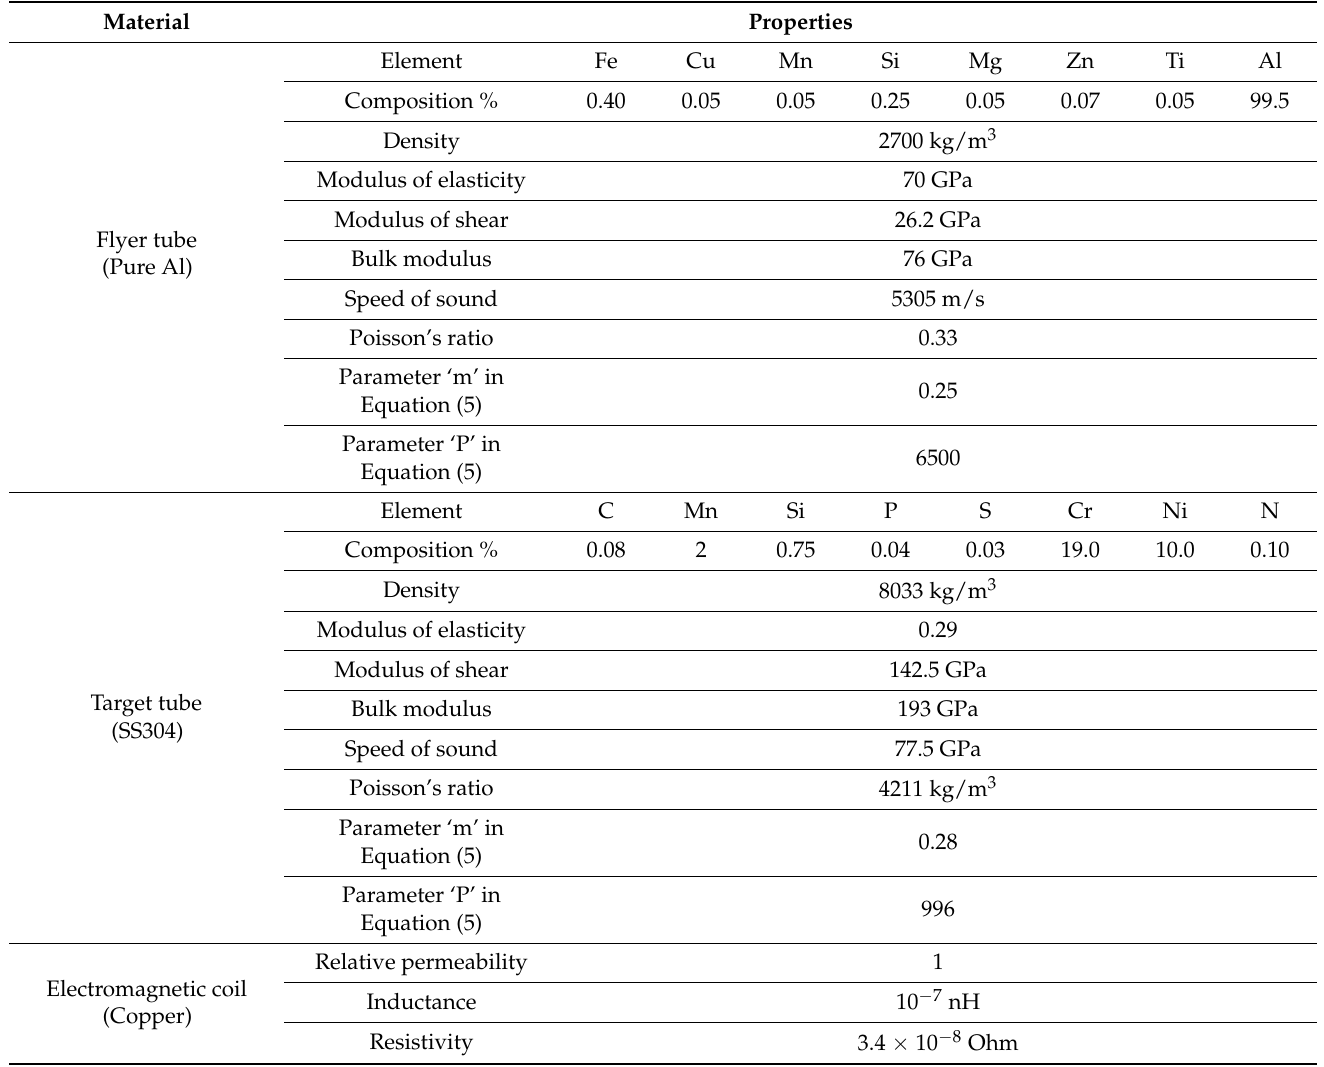
Table 4. Chemical composition and material properties of flyer and target tubes and electromagnetic